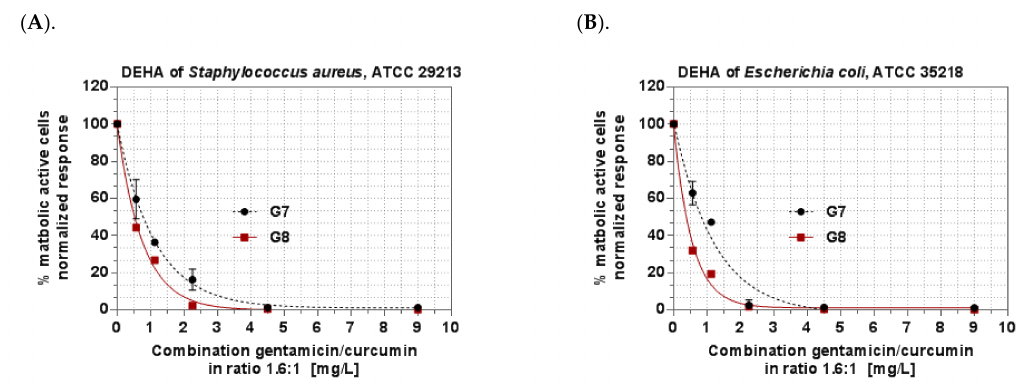
Figure 9. Metabolic activity of S. aureus and E. coli treated with a combination of curcumin and gentamicin in the ratio 1:1.6 wt:wt. ( A ). DEHA activity of Staphylococcus aureus after treatment with combination gentamicin/curcumin in ratio 1.6:1. ( B ). DEHA of Escherichia coli after treatment of combination gentamicin/curcumin in ratio 1.6:1. Legend: DEHA—dehydrogenase activity. The con- centrations plotted on the X-axis represent the sum of the concentrations of gentamicin and